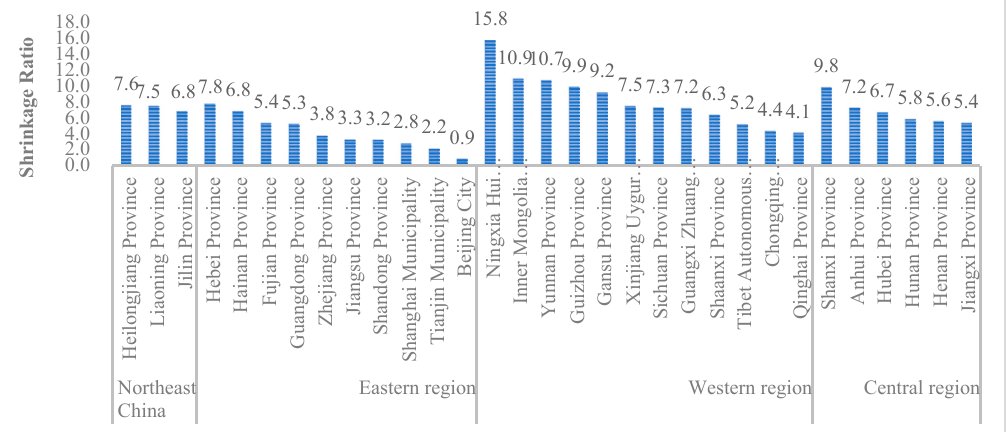
Figure 4. The average degree of urban shrinkage in provinces. Land 2023 , 12 , x FOR PEER REVIEW